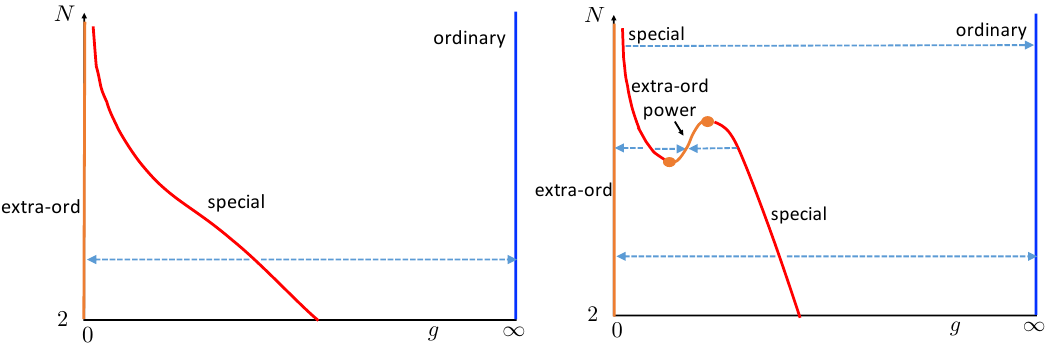
Figure 5: Conjectured RG flows as a function of N in d = 3 + ε . Left - scenario I. Right - scenario II. Blue dashed arrows indicate the direction of RG flow. In scenario II, as ε increases the figure on the right will eventually evolve into the figure on the